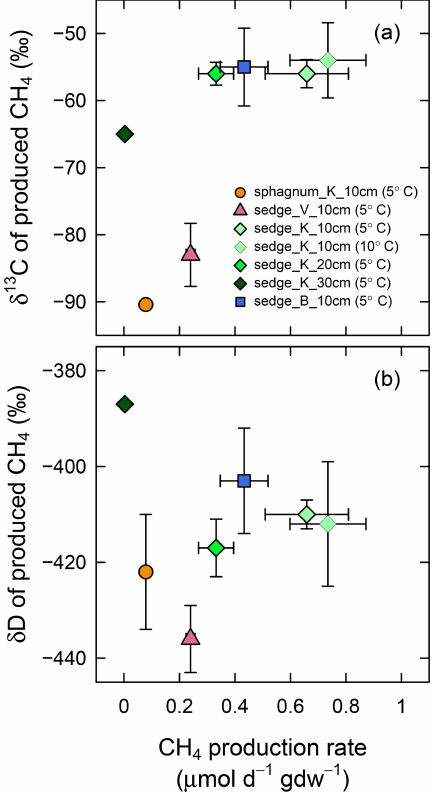
Figure 7. (a) δ 13 C and (b) δ D of produced CH 4 versus CH 4 pro- duction rate in the anaerobic soil incubation experiment. Produc- tion rates are shown in micromoles of produced CH 4 per day and per weight of dry soil in grams. Soil samples were collected at four observation points (sphagnum_K, sedge_V, sedge_K, and sedge_B) at three depths (10, 20, and 30cm) and incubated at two tempera- tures (5 and 10 ◦ C). These samples contain organic layers except for those collected at 30cm. Error bars represent standard